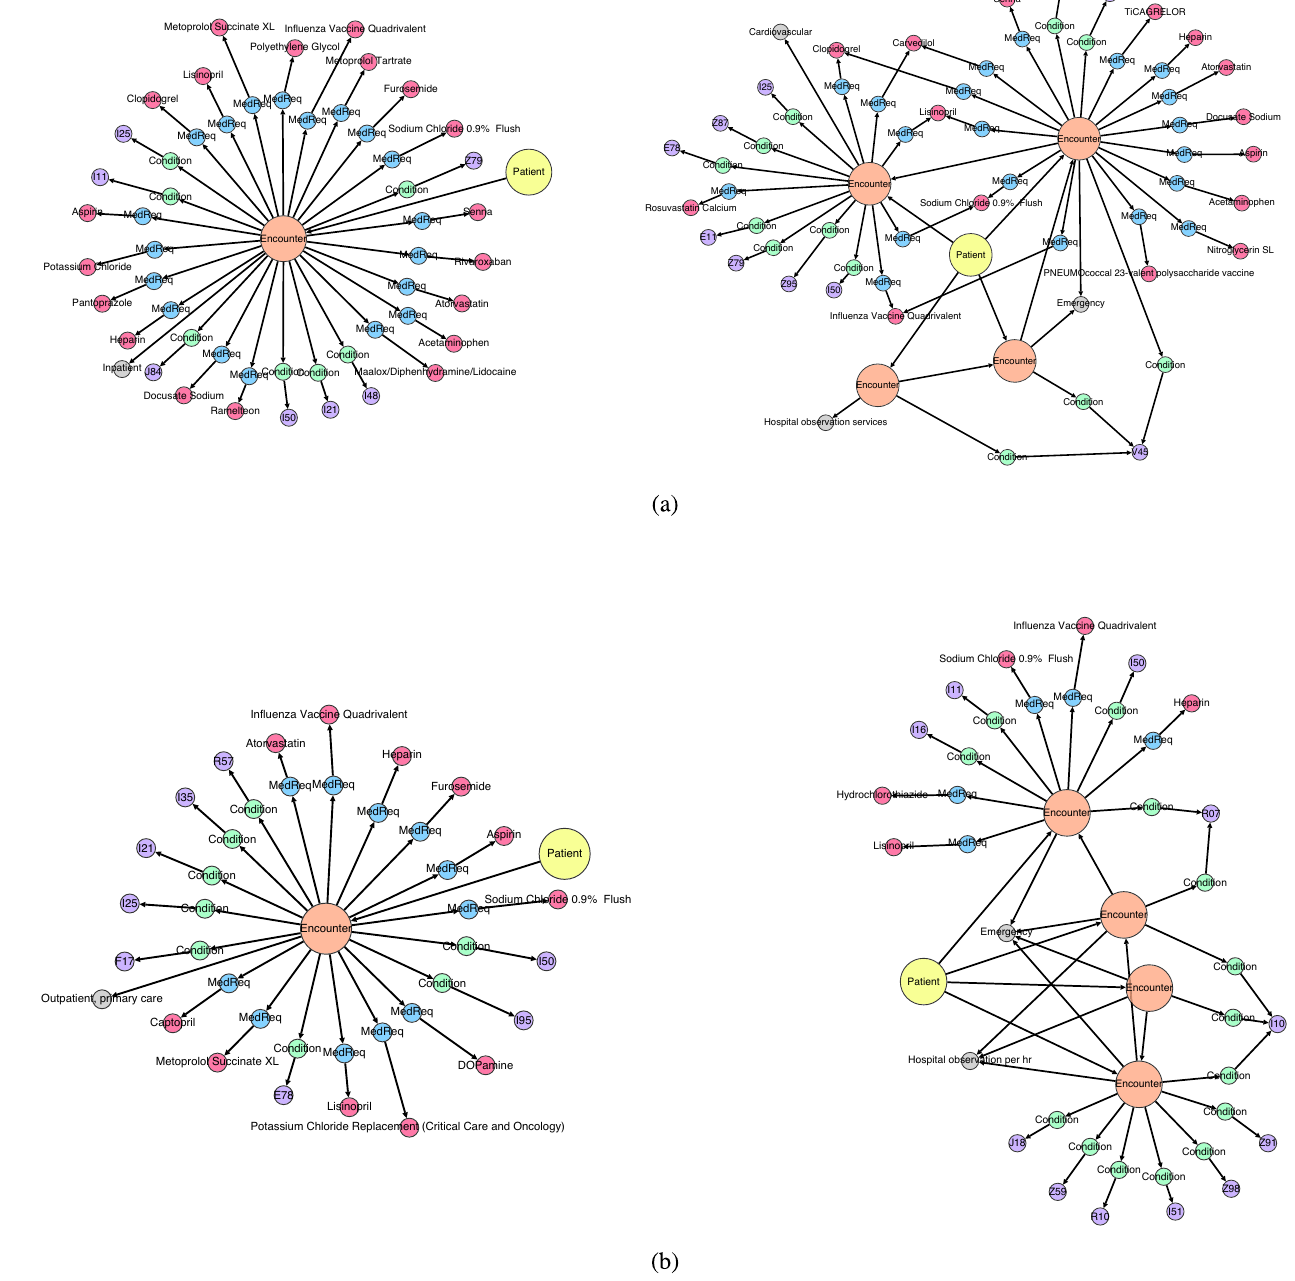
Fig. 10 Visualizations of patient trajectories. a Two examples of trajectories extracted from the training data. b Two examples of synthetic trajectories that were generated with the proposed for re-identi fi cation. In our model, the amount of similarity between the synthetic and real trajectories is adjustable by the amplitude of the noise injected into the sampled latent space. Synthetic data should undergo a careful evaluation with respect to identity disclosure risks prior to distribution 52 . A number of different approaches for reducing the risk of information disclosure 53,54 have been proposed since disclosure control methods have a signi fi cant impact on data utility. To conclude, graph deep learning is a powerful tool for learning complex data patterns. Here, a variant of a variational graph autoencoder (VGAE) tailored to patient trajectories represented as large directed acyclic graphs created privacy-preserving and